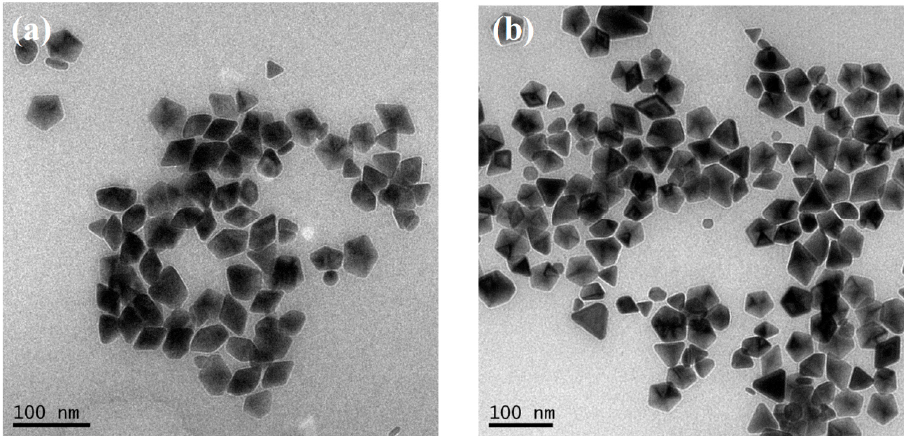
Figure 8. TEM images of AgNPs after the reconstruction processes at ( a ) 10 °C and ( b ) 60 °C. The stability of D-AgNPs reconstructed at different bath temperatures is different.